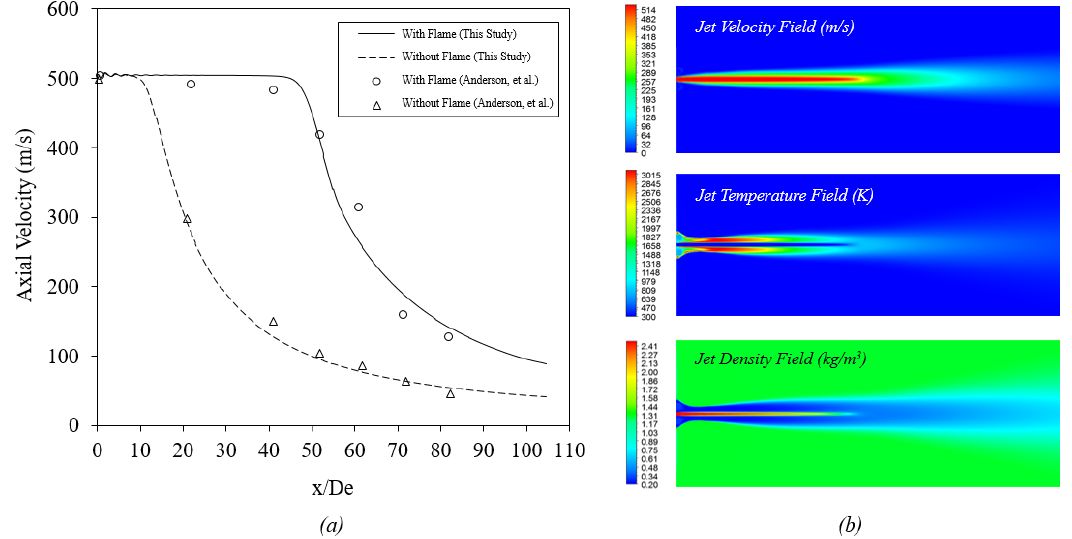
Figure 6. ( a ) Jet axial velocity distribution with & without shrouding flame; ( b ) Velocity, temperature, density field distribution of the supersonic coherent jet.